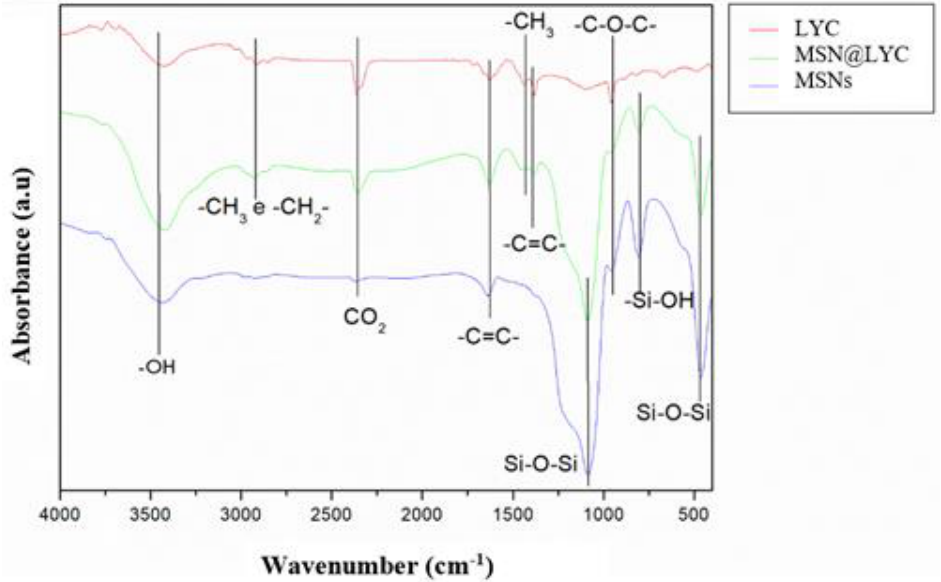
Figure 2. The infrared spectra of LYC, NSM and NSM@LYC diluted in KB pellet. Legend: LYC: free lycopene. MSN@LYC: mesoporous silica nanoparticle incorporated with lycopene. MSN: pure mesoporous silica nanoparticle. Table 2. The minimum inhibitory concentration of the groups